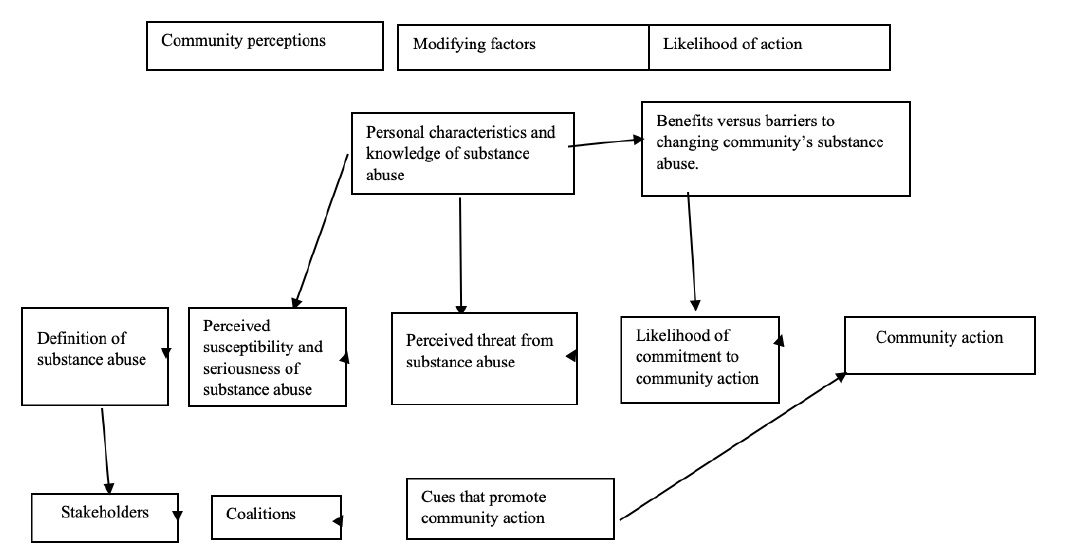
Figure 1: A Visual Presentation of The Health Belief Model Exploring Community Action in Substance Abuse Issues;